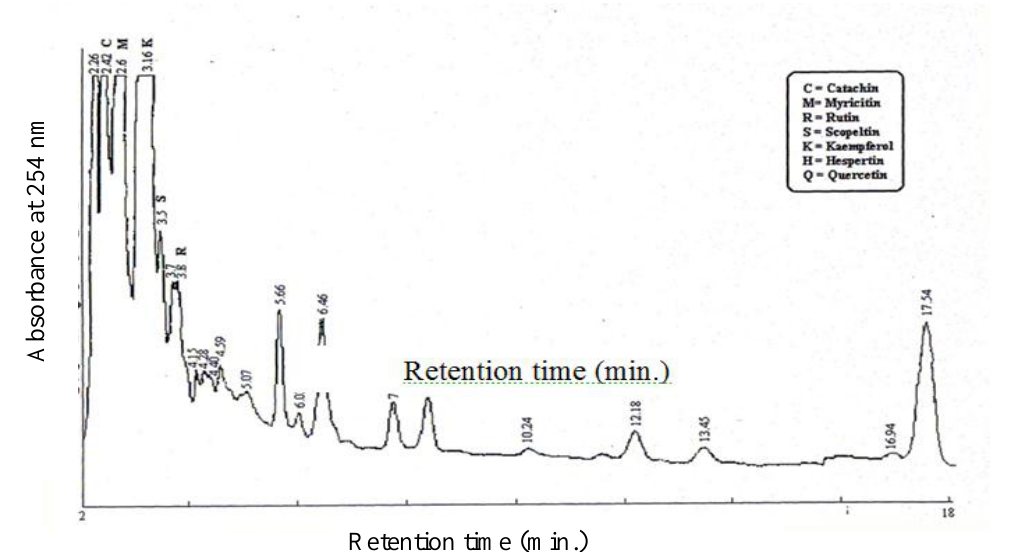
Retention time Figure 2: High performance liquid chromatography of Black Cumin flavonoids.